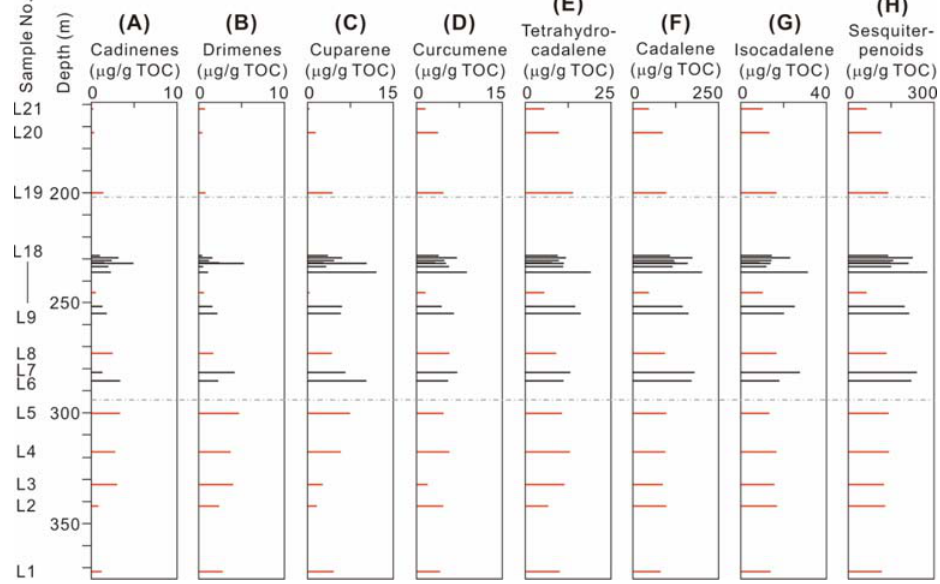
Figure 10. Sesquiterpenoids in saturated and aromatic hydrocarbon fractions of oil shale and coal. ( A ) Cadinenes. ( B ) Drimenes. ( C ) Cuparene. ( D ) Curcumene. ( E ) Tetrahydro-cadalene. ( F ) Cadalene. ( G ) Isocadalene. ( H ) Total sesquiterpenoid concentration. The red bar represents oil shale, and the black bar represents coal. The two horizontal grey lines show the boundaries of the three units.